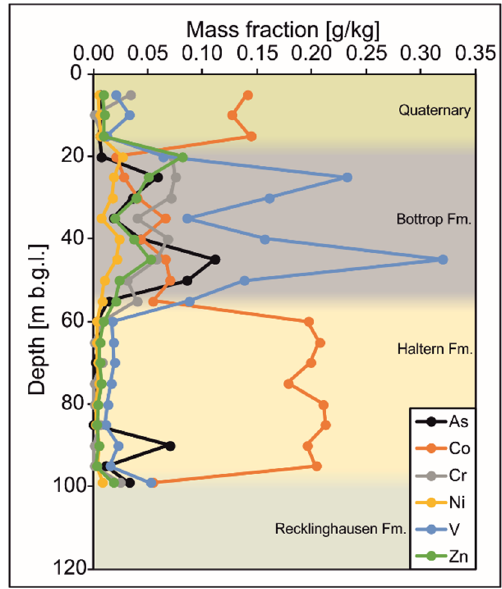
Figure 6. Trace element contents of the Haltern Fm. aquifer .